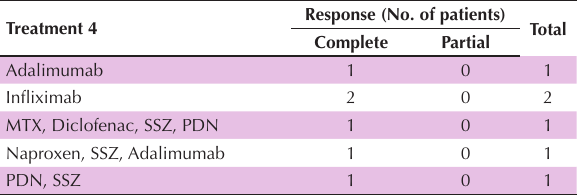
Table 12 . Treatment response status (complete or partial) of drugs used in the fourth treatment of the disease Treatment 4